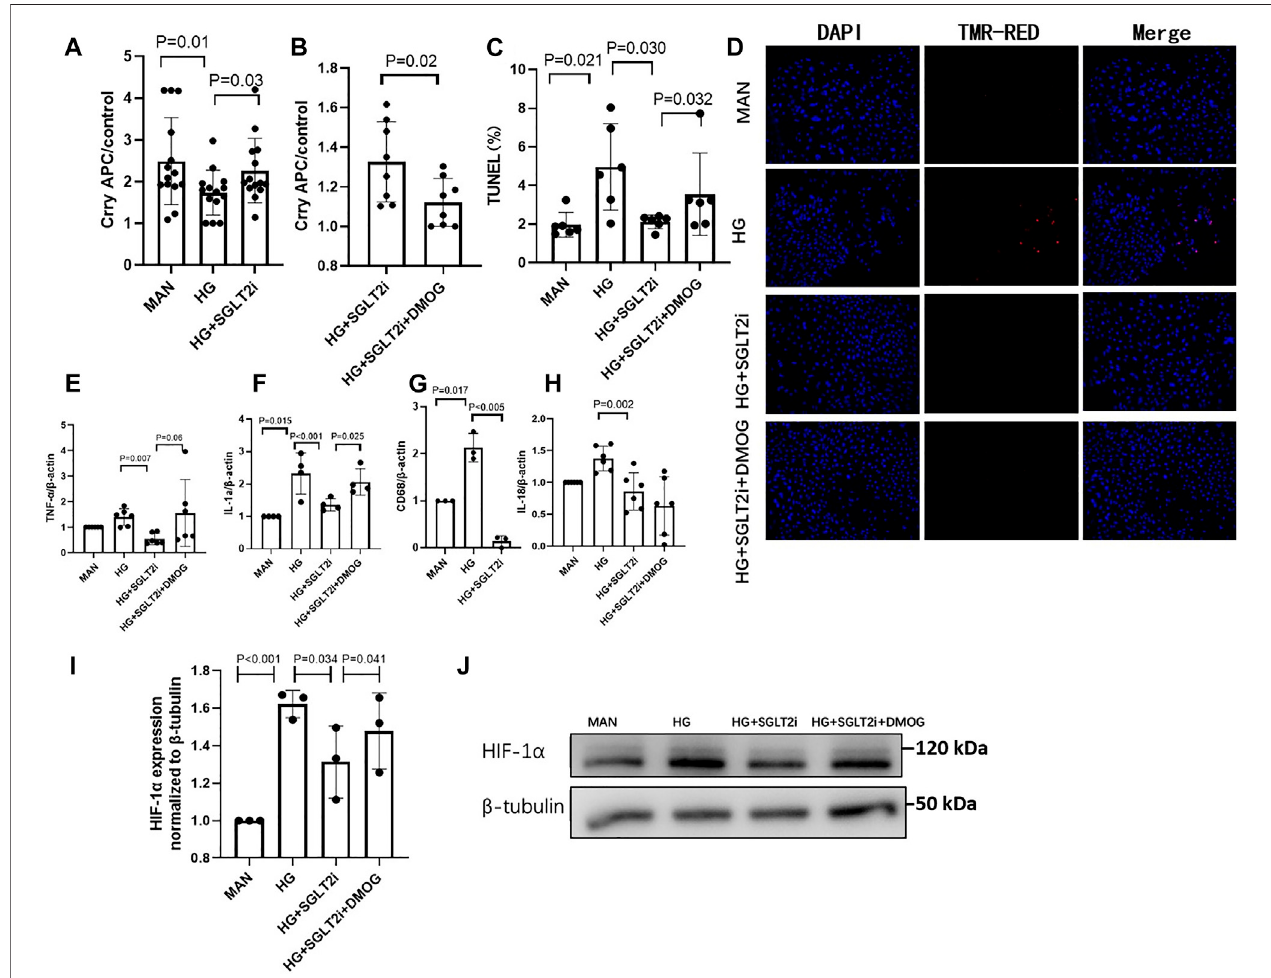
FIGURE3| Dapagli fl ozinrelievedtubularinjurybyupregulating Crryandinhibitinghighglucose-induced HIF-1 α accumulation invitro . (A) InMPTECs, dapagli fl ozin upregulatedCrryunderHGcondition(30 mmol/L). (B) TheupregulationofCrrywassigni fi cantlyreducedbyDMOG(1 mmol/L), aHIF-1 α stabilizer. (C,D) Theapoptosis ratio was analyzed by TUNEL assay. Dapagli fl ozin signi fi cantly reduced apoptosis ratio of MPTECs and the protective effect was reduced by DMOG. Real-time qPCR analysis of mRNA level change (E) TNF- α , (F) IL-1 α , (G) CD68, (H) IL-18, (I) and (J) Protein expression levels of HIF-1 α were determined by western blot analysis and quantitated by densitometry. MPTECs, mouse primary proximal tubular epithelial cells; DMOG, dimethyloxallyl glycine.